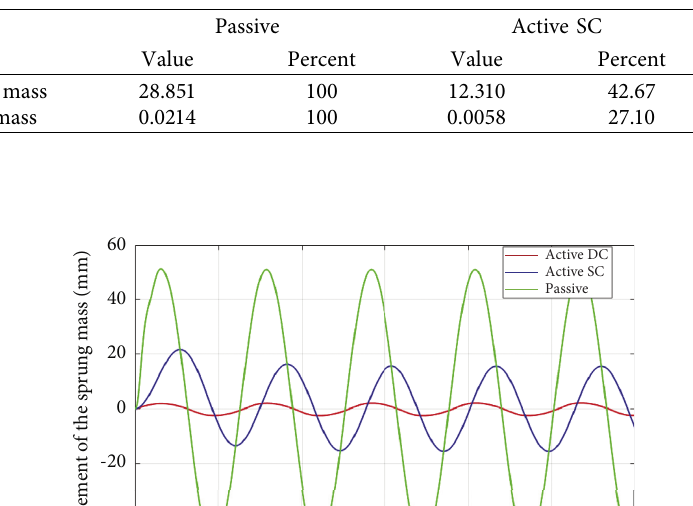
Table 4: The average value of case 1.